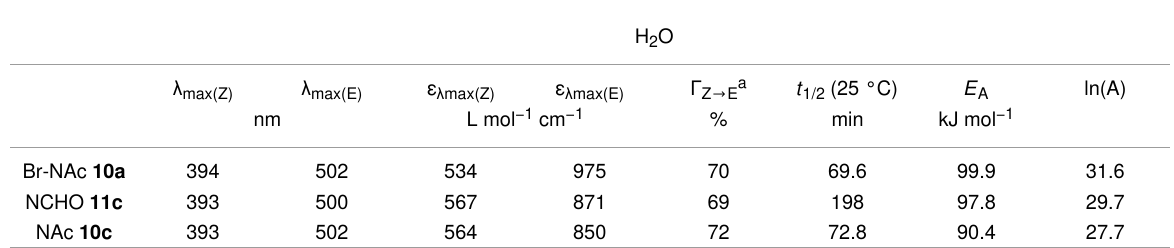
Table 2: Photophysical properties of water-soluble N -diazocines 10a , 10c , and 11c in H 2